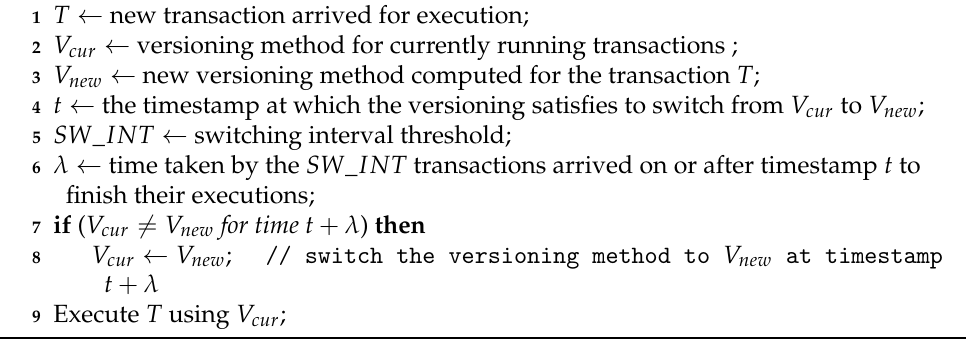
Algorithm 4: Better Switching Mechanism